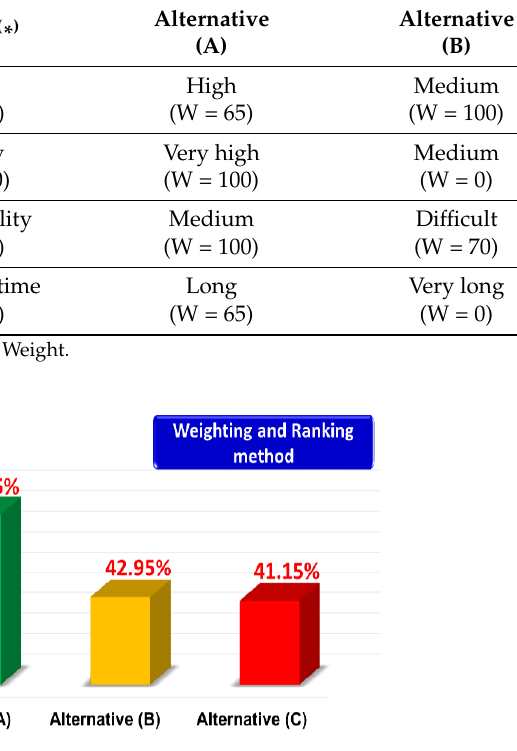
Figure 11. Result of the weighting and ranking method as applied to the solution alternatives.